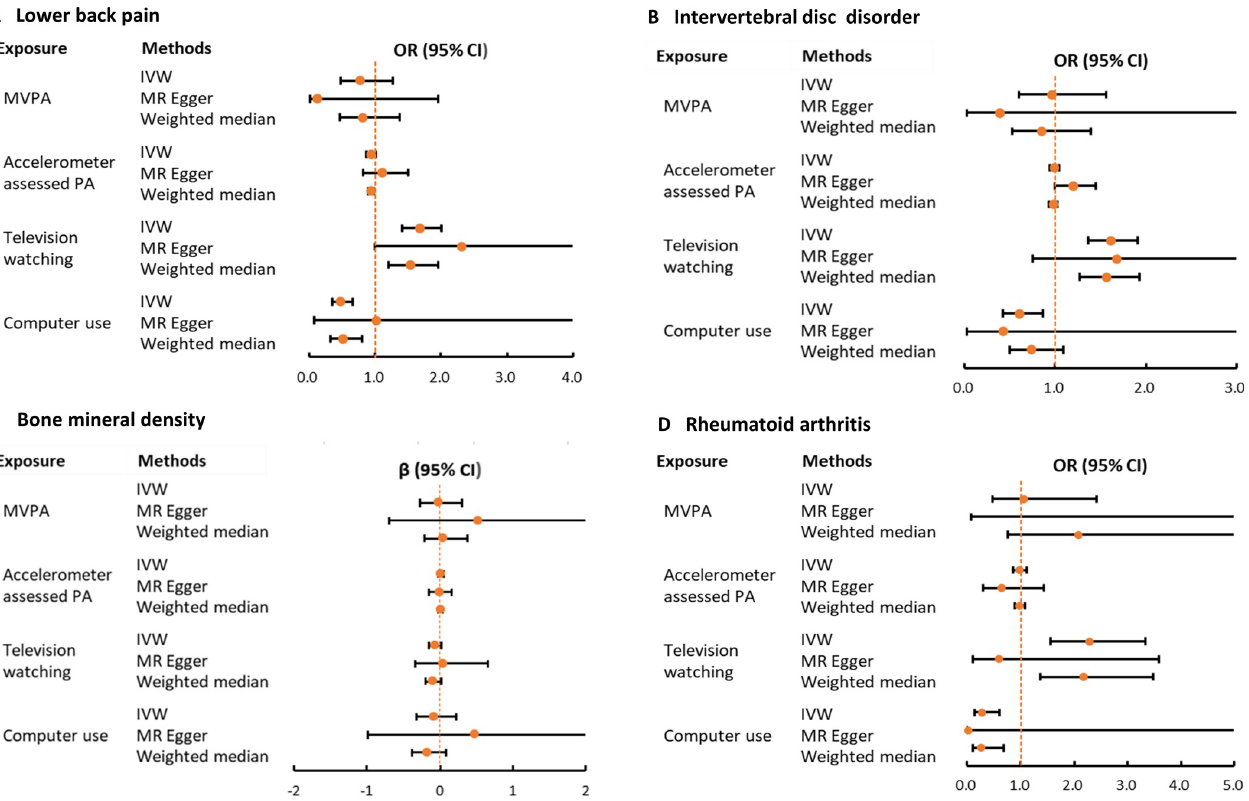
Fig 2. Causal effects for PA/LSB on lower back pain (A), intervertebral disc disorder (B), bone mineral density (C) and rheumatoid arthritis (D). Summarized Mendelian randomization (MR) effect sizes were derived from the inverse variance weighted (IVW), MR-Egger and weighted median methods. PA, physical activity; MVPA, moderate to vigorous physical